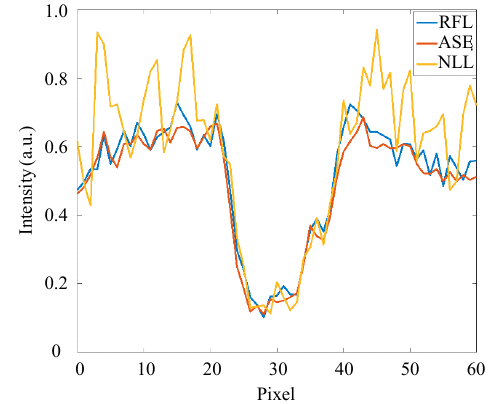
Fig. 6 Intensity fluctuation of the caries